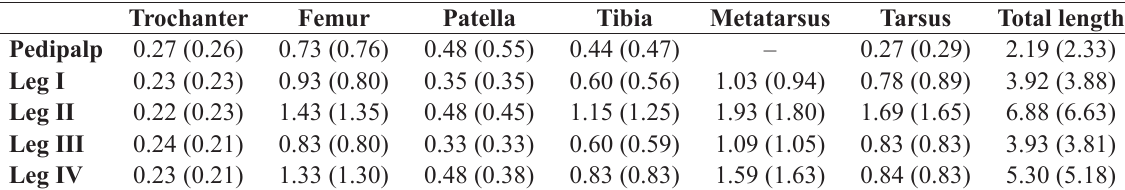
Table 10. Length of appendage-segments in millimeters in N. bidentatum martensi Novak, Slana Novak & Raspotnig ssp. nov. from Poljane pri Podgradu, Slovenia: ♂ holotype